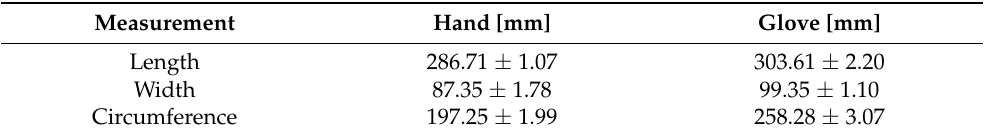
Absolute and relative DAs were calculated based on the gathered data of the bare and gloved hand. For linear dimensions, i.e., length and width, the absolute DA was defined as a difference between the subject with and without the protective glove according to the Formula (6). For the circumference, Cloud-to-Cloud distance computation between the bare and gloved hand with the use of CloudCompare software was applied. Relative DAs were considered in this study to understand the relation of changes between the bare